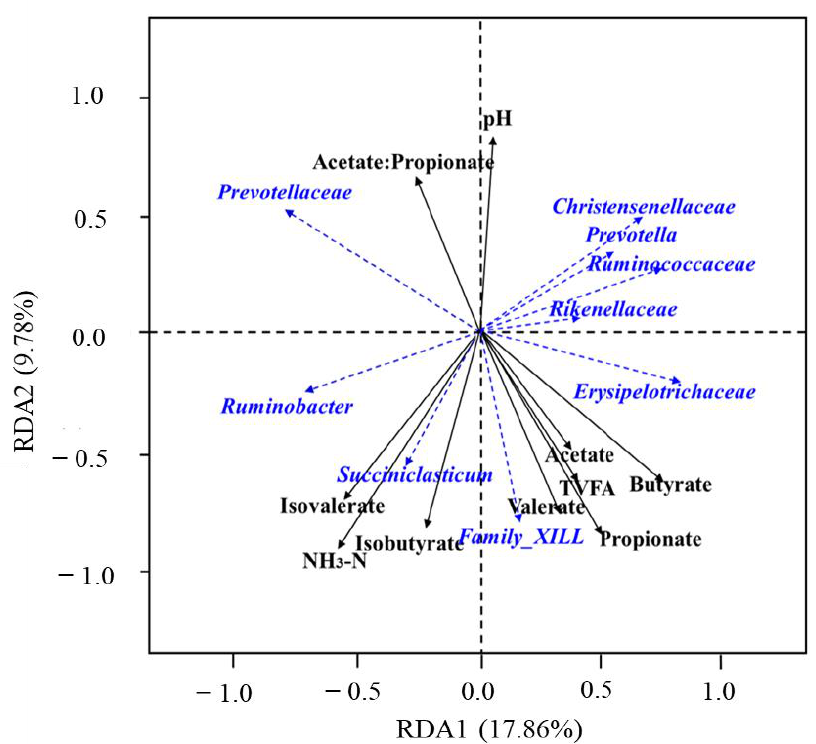
Figure 7. Redundancy analysis (RDA) of the relative abundance of sheep rumen microbes and rumen environmental factors under different replacement ratio levels of endophyte-free Achnatherum inebrians (EF). The black solid lines indicate rumen environmental factors, and blue dashed lines indicate rumen microbes. TVFA, total volatile fatty acid; NH 3 -N: ammonia nitrogen.